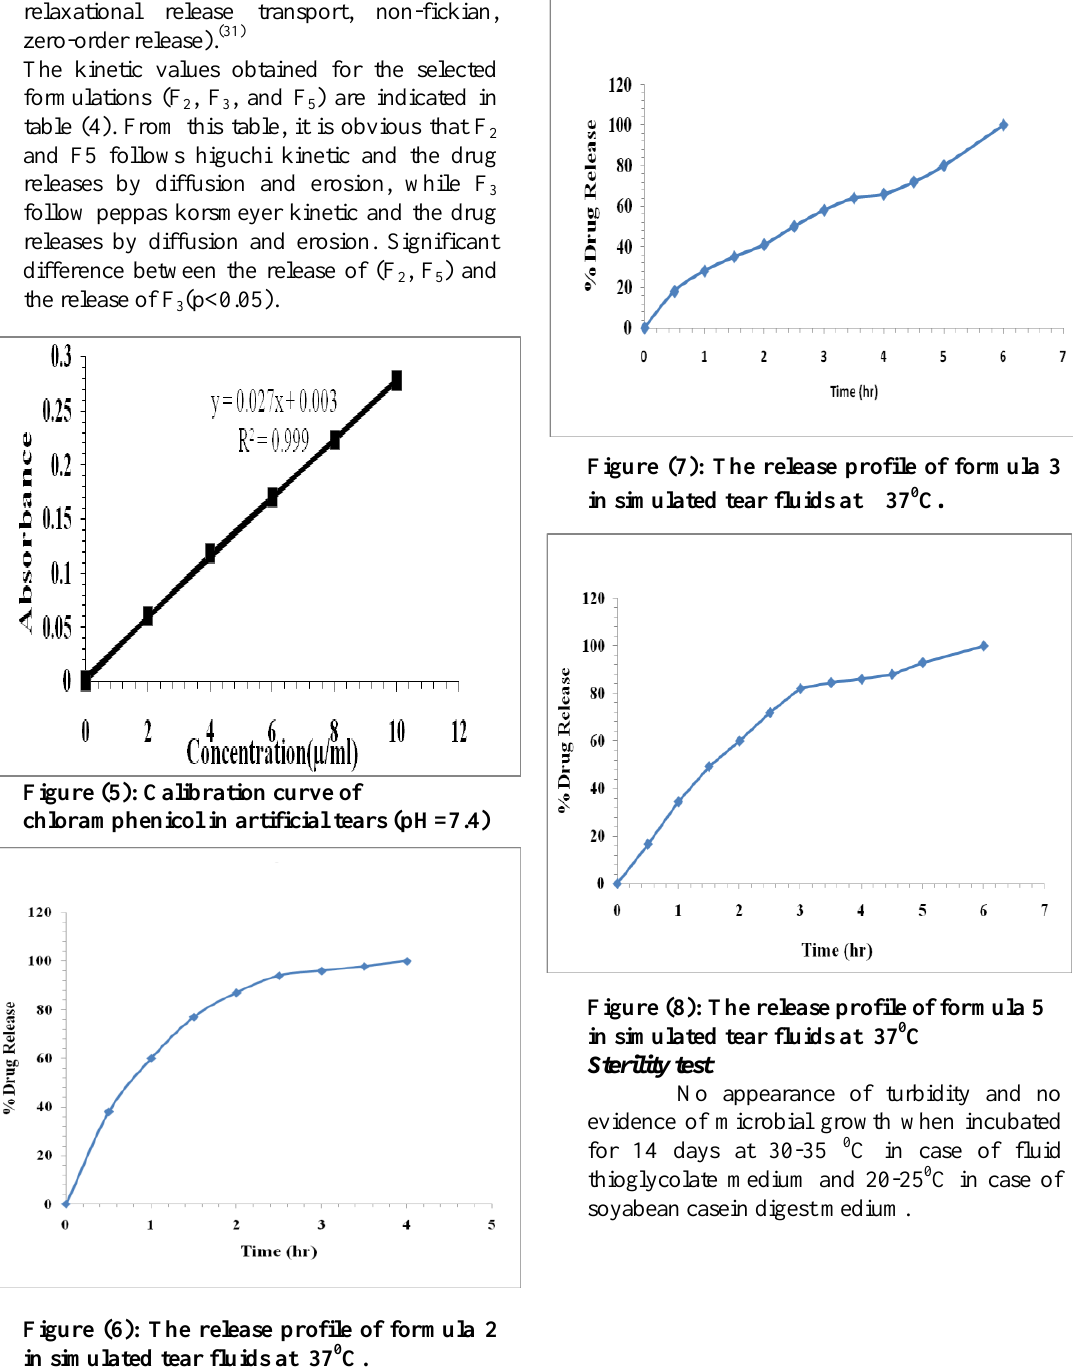
Table (4): Drug release kinetics of F